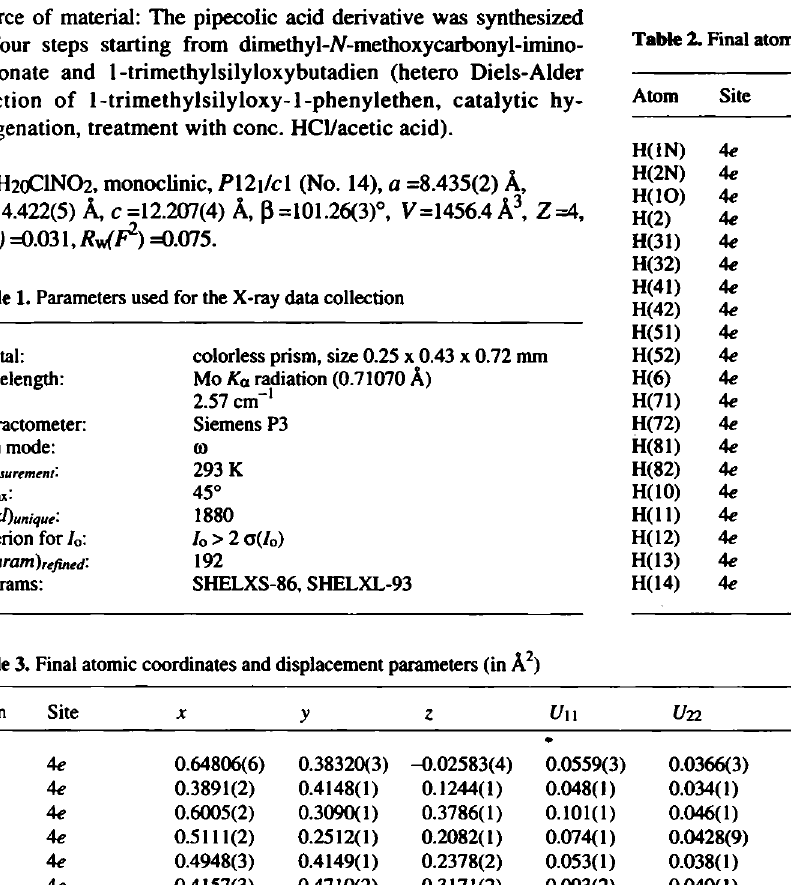
Table 3. Final atomic coordinates and displacement parameters (in Â 2 ) Atom